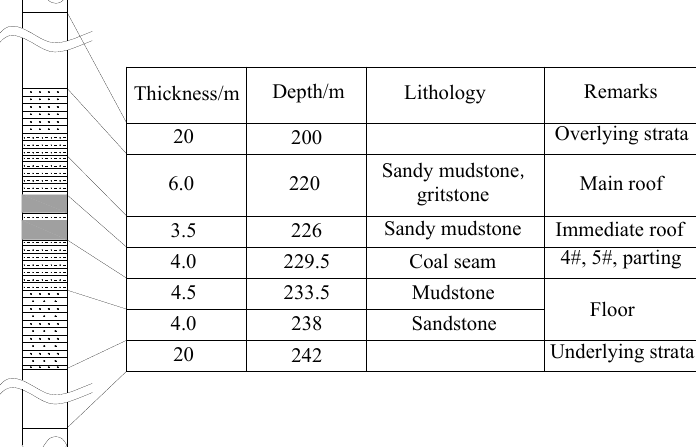
Figure 2. Generalized stratigraphic column for the 4211 panel.